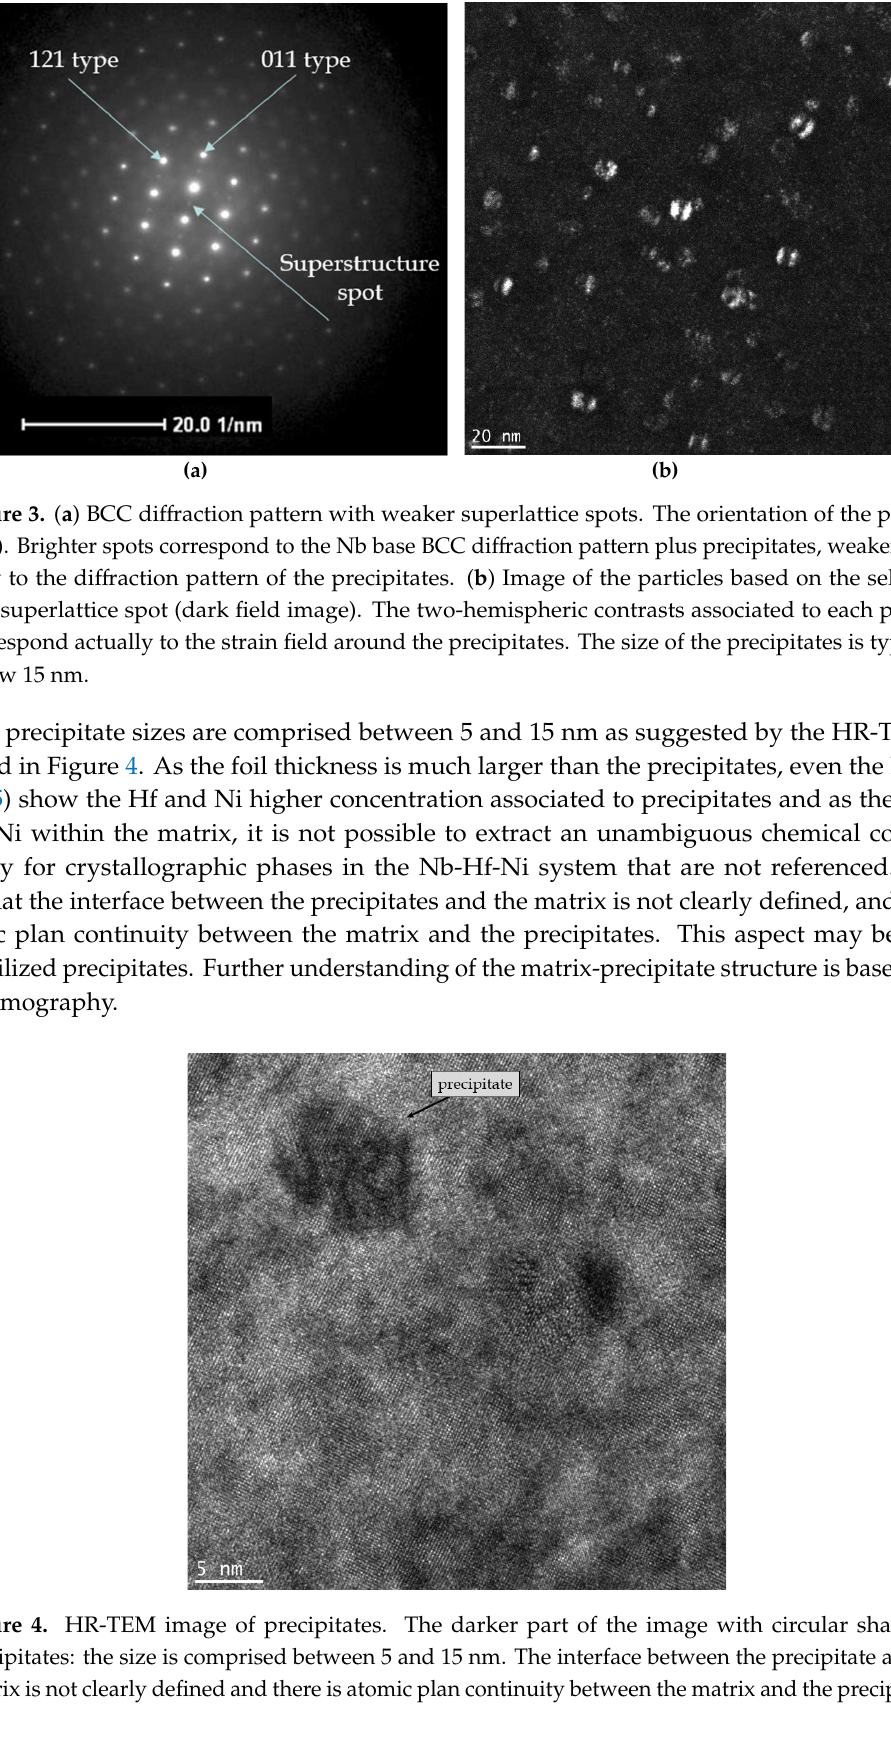
Figure 4. HR-TEM image of precipitates. The darker part of the image with circular shape are precipitates: the size is comprised between 5 and 15 nm. The interface between the precipitate and the matrix is not clearly defined and there is atomic plan continuity between the matrix and the precipitates.